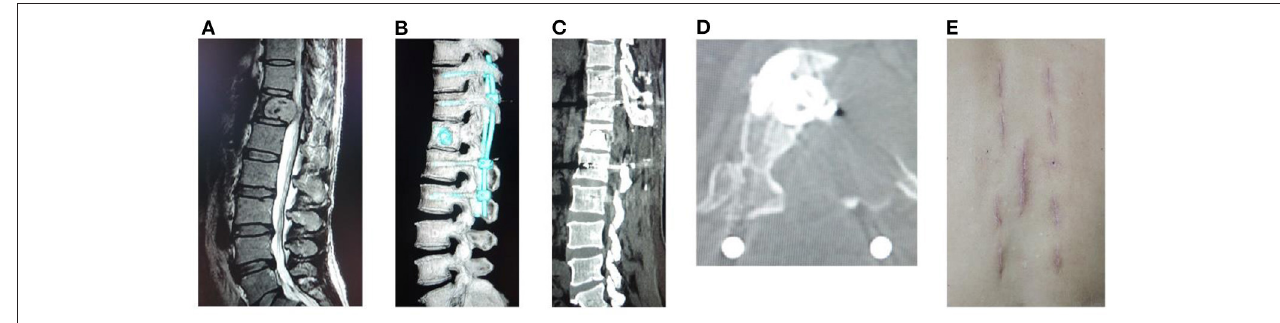
FIGURE 3 | A male patient of 67 years old with T12 metastasis and neurologic compression from HCC had back pain VAS 9, ASIA B, Tomita 6, modified Tokuhashi 11, ESCC grade 3, and SINS 8. He underwent freehand MIPS + PVP, minimally invasive decompression, and partial tumor resection, with an operation duration of 215min, intraoperative blood loss of 90ml, incision length of 3.5cm, and stay in hospital of 5 days. (A) Sagittal MRI showed metastasis of T12 with neurologic compression. (B) Sagittal CT reconstruction. (C,D) Sagittal and axial CT showed complete decompression and no leakage of cement into the spinal canal. (E) Incision after minimally invasive surgery.